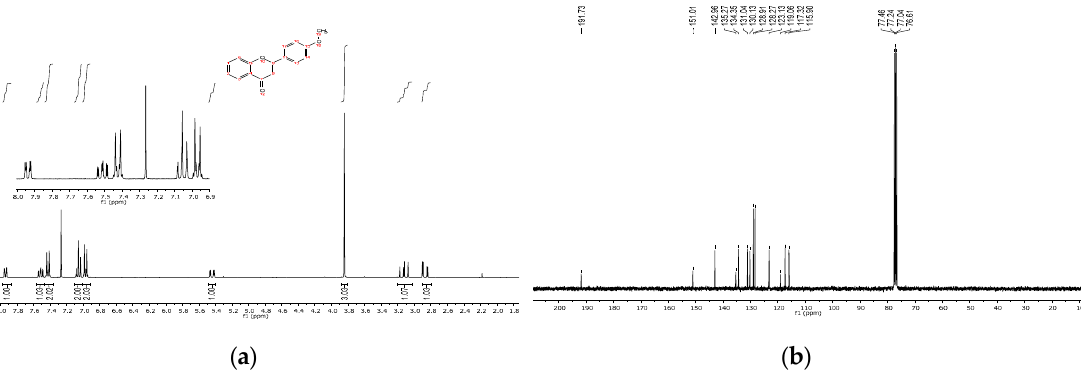
Figure 6. ( a ) 1 H NMR spectrum of the 4-methoxyflavanone 4b; ( b ) 13 C NMR spectrum of the 4-methoxyflavanone 4b.